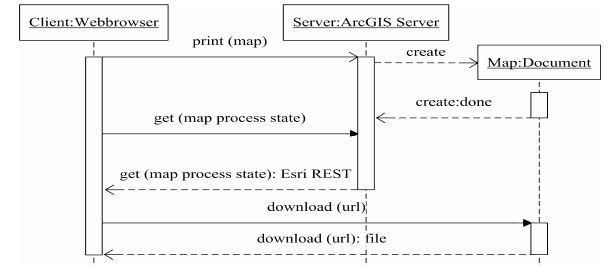
Figure 3. Sequence diagram for map product